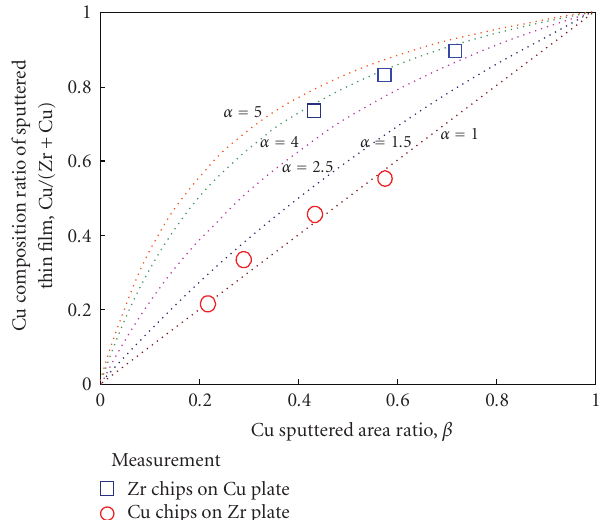
Figure 4: Relationship between Cu composition ratio of sputtered films and Cu sputtered area ratio of elemental composite targets.